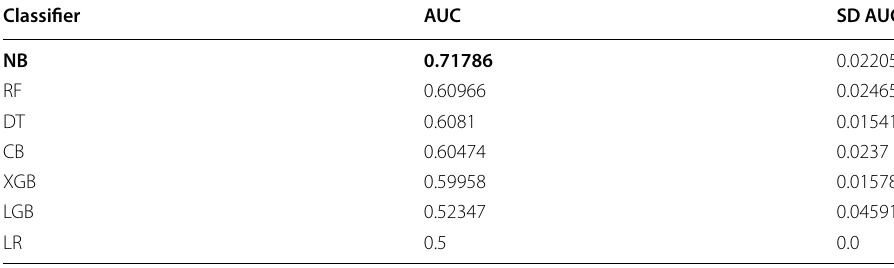
Table 8 Results for classification of Brute Force web attacks and no sampling applied; classifiers: RF is Random Forest, CB is CatBoost, NB is Naive Bayes, LR is Logistic Regression, DT is Decision Tree, XGB is XGBoost, LGB is LightGBM; AUC stands for Area Under the Receiver Operating Characteristic Curve; SD stands for standard deviation Classifier AUC SD AUC NB 0.71786 0.02205 RF 0.60966 0.02465 DT 0.6081 0.01541 CB 0.60474 0.0237 XGB 0.59958 0.01578 LGB 0.52347 0.04591 LR 0.5 Bold value indicates highest score